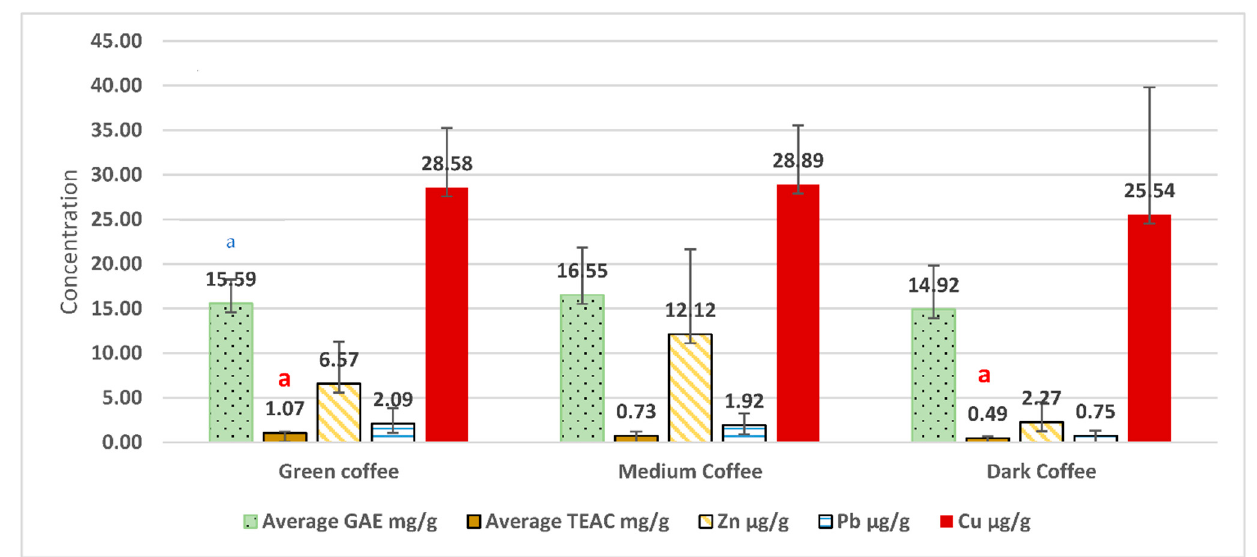
Figure 4. Comparison of coffee samples of three different roasting degrees (regardless of their origin) in terms of average GAE in mg/g, average TEAC in mg/g, and average Zn, Pb, and Cu contents in µ g/g. (Data for heavy metal content was taken from Albals et al. [7]). Bars labeled a are statistically significant with a p -value <